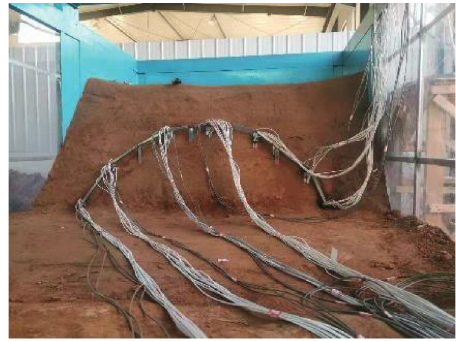
Figure 16: Slope